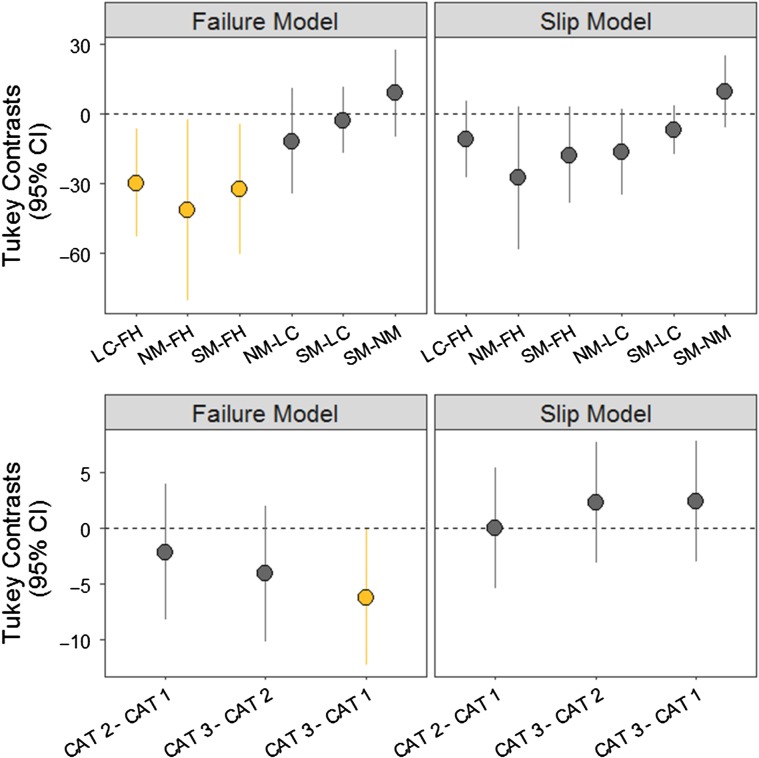
Tukey contrasts (estimate ± 95% confidence interval) between rivers (top row) and CAT trial numbers (bottom row) for failure (Uburst) and slip (Uslip) velocities from linear mixed-effects models; Significant differences (P < 0.05) are denoted in yellow; Rivers are abbreviated as follows: Flathead River (FH), St. Mary River (SM), Lee Creek (LC) and North Milk River (NM)